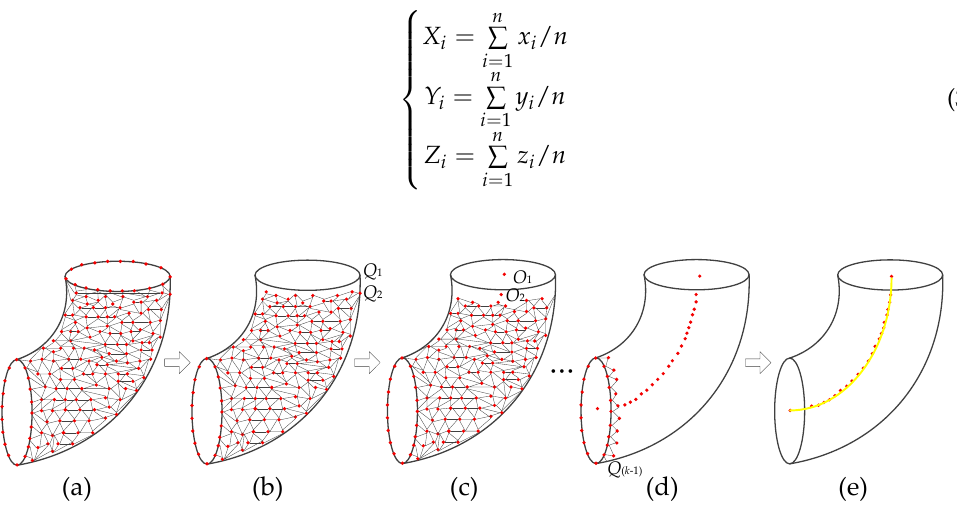
Figure 11. The process of representative edges extraction on a triangulated MEP element: ( a ) tri- angulate an MEP element; ( b ) delete boundary points; ( c ) extract the center point of new boundary points; ( d ) extract all center points; ( e ) generate representative edges.